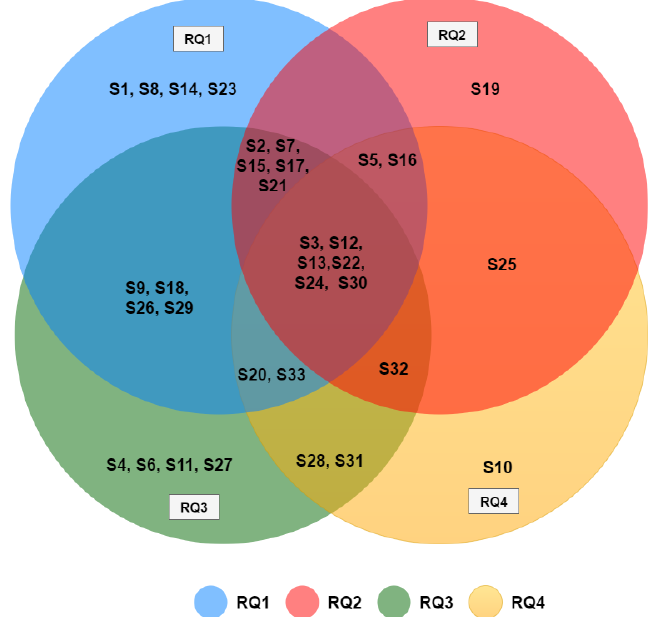
Figure 3. Selected studies per research question ( RQ ).